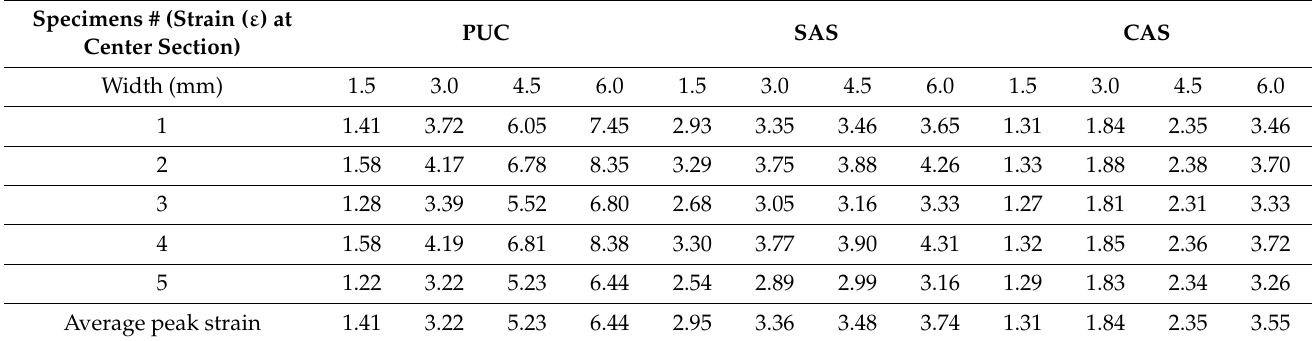
Table 5. Strain measurement results for each strain gauge points (averaged peaks).